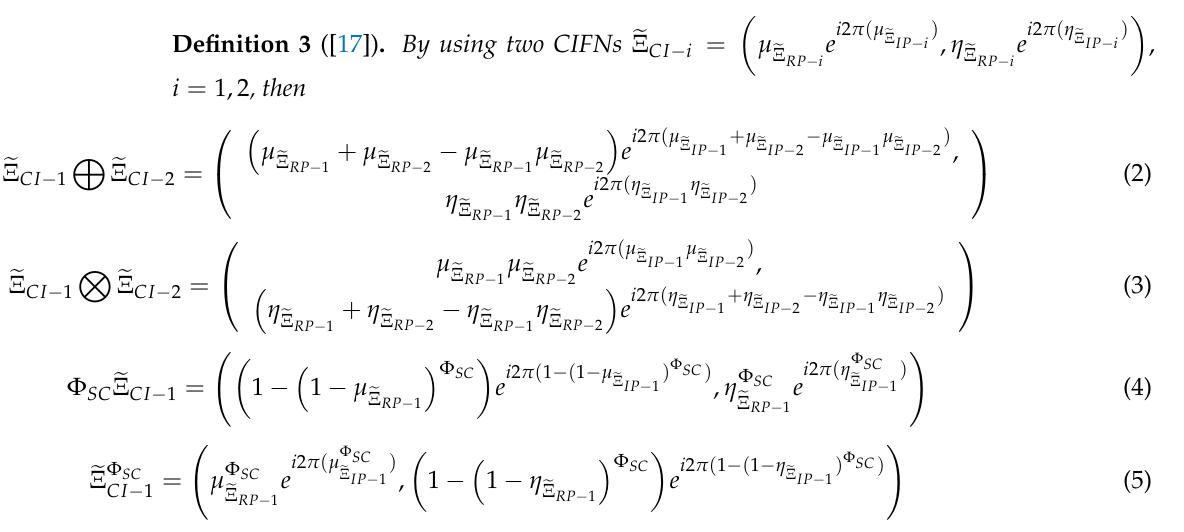
Figure 1. Geometrical expressions of the unit disc.